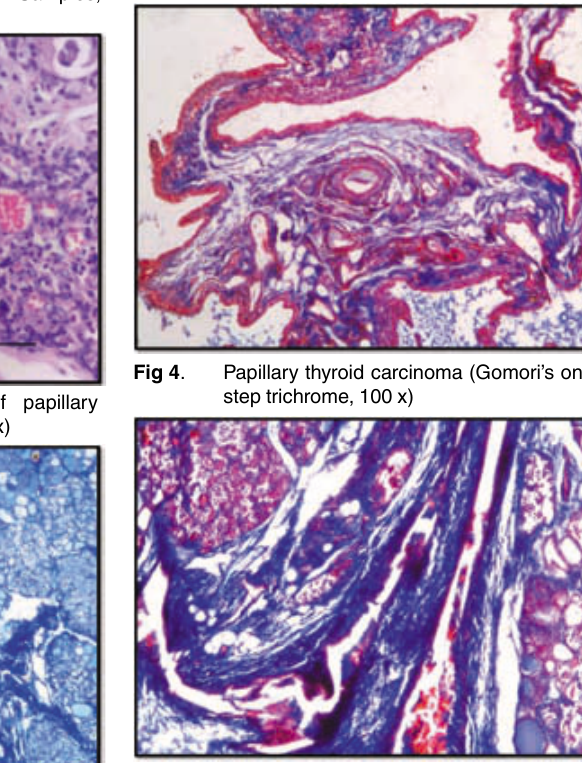
Fig 2. Diffusely pale thyroid glands